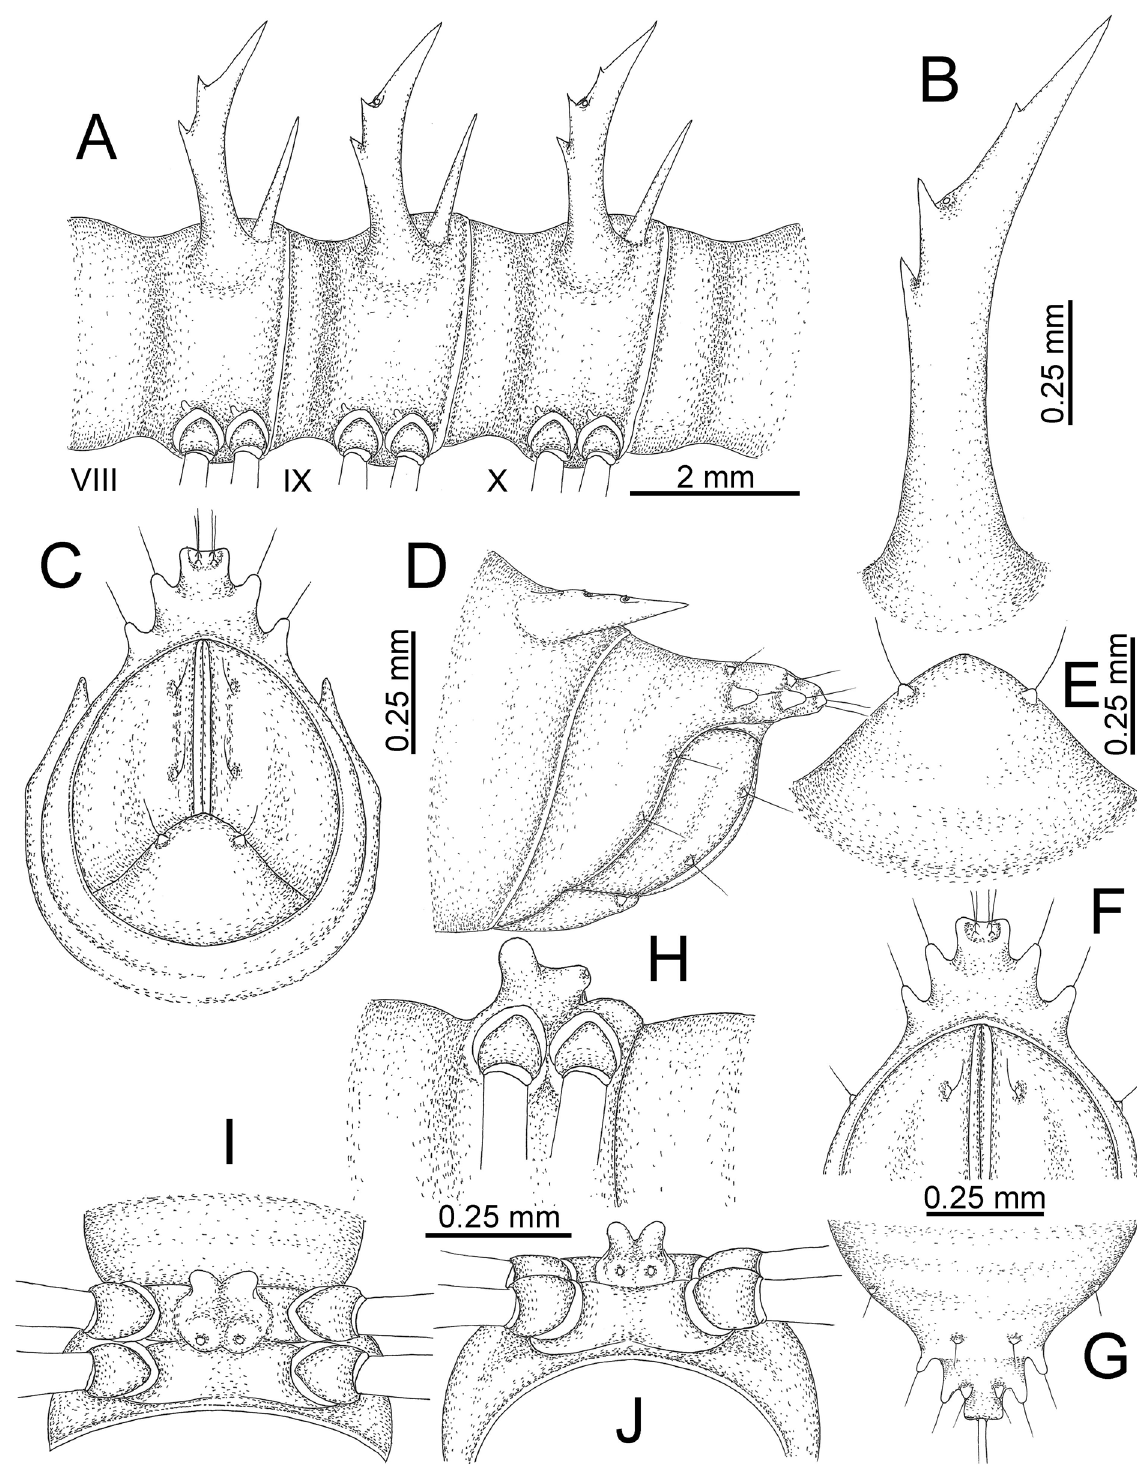
Fig. 19. Nagaxytes gracilis Srisonchai, Enghoff & Panha gen. et sp. nov., ♂, paratype (CUMZ- pxDGT00091). A . Body rings 8–10. B . Paraterga of ring 10. C – D . Last ring and telson. E . Hypoproct. F – G . Epiproct. H – J . Sternal lobe between coxae